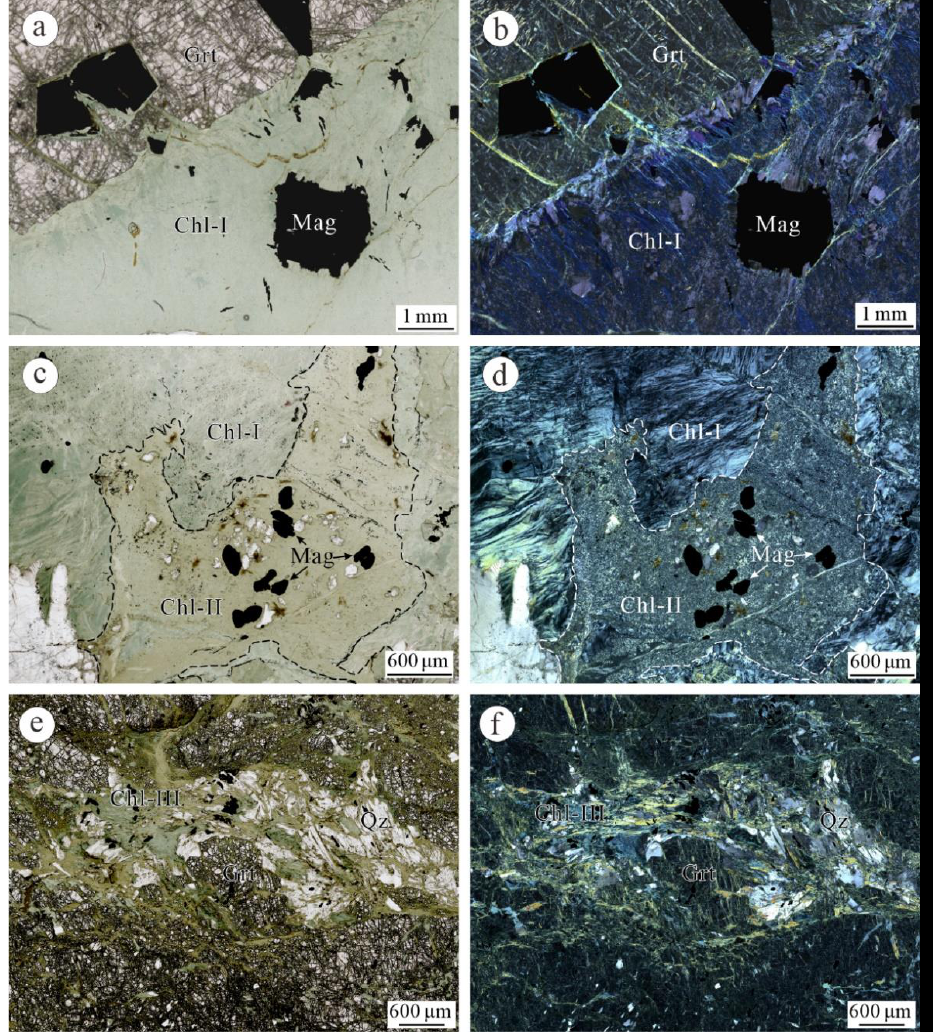
Figure 3. The textures of different chlorite. The photos are collected under microscopy with plane- polarized light (images on the left) and cross-polarized light (images on the right). ( a , b ) Chlorite-I with abnormal interference color of purple exhibiting straight cantact boundary with garnet; ( c , d ) Chlorite-II infilled in the fissures of lamellar chlorite (Chl-I) and some anhedral fine grained magnetites were included in it; ( e , f ) Chlorite-III and anhedral quartz dissolved and replaced garnet.